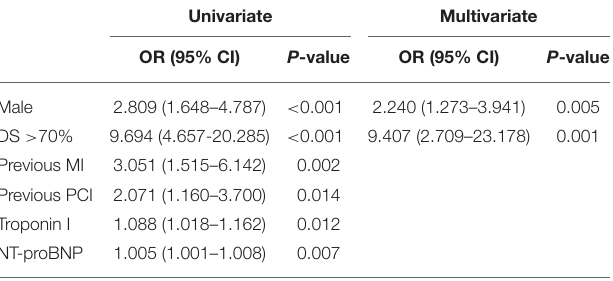
TABLE 4 | Univariate and multivariate regression analysis for predicting positive cQFR. Univariate Multivariate